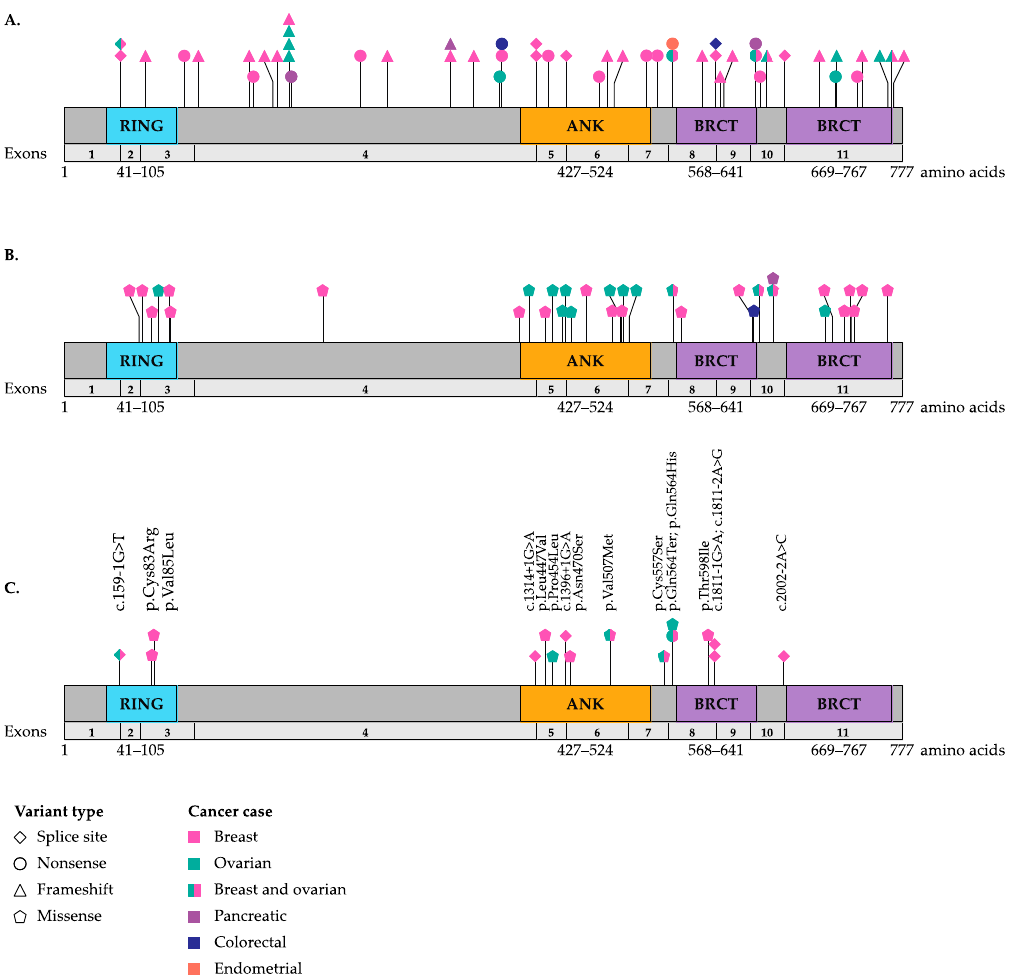
Figure 2. Potentially pathogenic germline variants reported in the literature mapped to full length BARD1 transcript including RING, ANK and BRCT encoding domains. ( A ) Predicted loss-of-function variants including nonsense, frameshift and canonical splice site variants. ( B ) Missense variants predicted to be damaging by in silico tools and conservation tools. ( C ) Variants discussed in the review. RING = Really Interesting New Gene domain; ANK = Ankyrin domain; BRCT = BRCA1 C Terminus domain. See Supplementary Table S1 for more information.